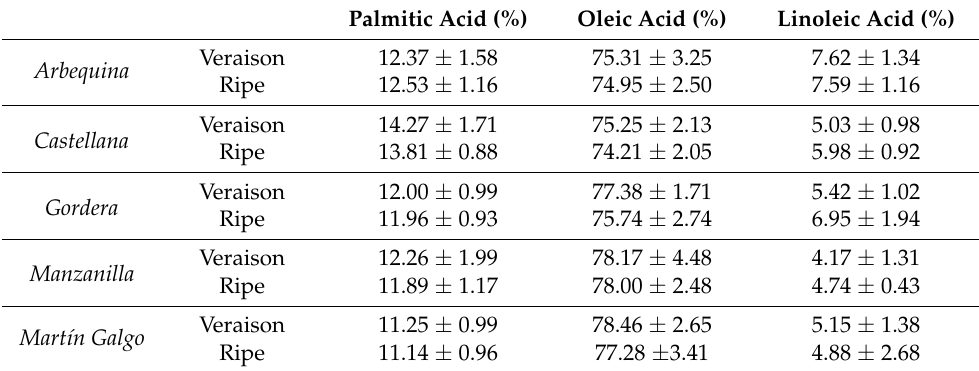
Table 3. Variation in the proportion of palmitic acid, oleic acid and linoleic acid, according to olive maturity, for the virgin olive oils produced with the variety of olives grown in the Aceite de la Alcarria PDO (veraison and ripe). The data show the mean values and the standard deviations for the samples collected across the four consecutive olive crop seasons under